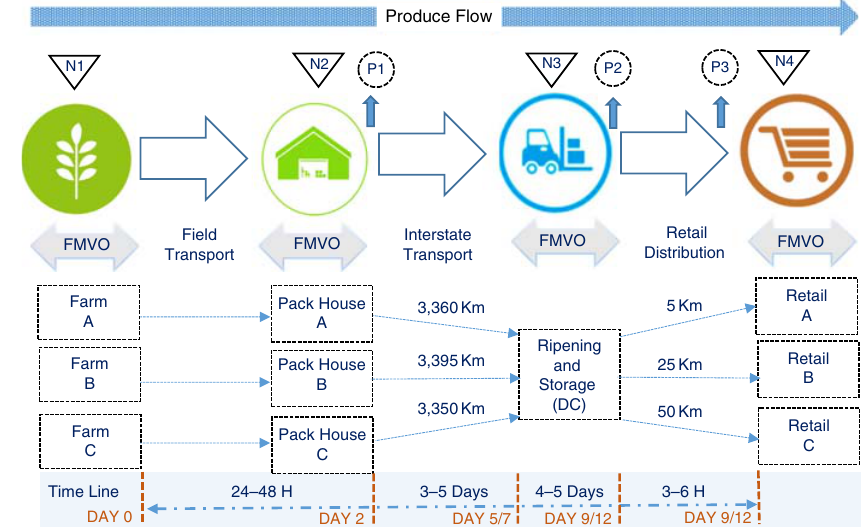
Figure 1. Key nodes (N1 –